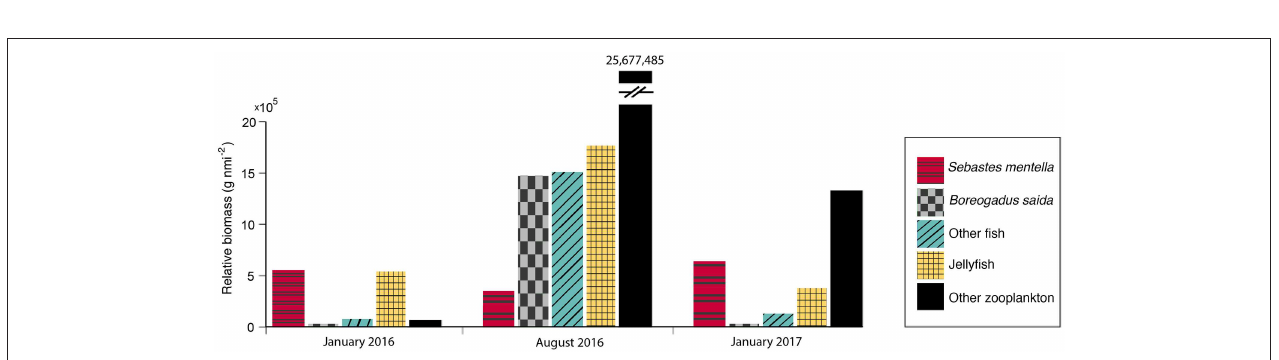
FIGURE 2 | Temperature-salinity diagrams averaged for each season with a 5-m vertical resolution. Bubble size indicates the distribution of the pelagic organisms in the SSL and is proportional to the nautical area scattering coefficient at 38kHz (s A ; m 2 nmi − 2 ) averaged over the same 5-m strata. Isopycnals indicate potential density (kg m − 3 ) and the regions corresponding to Atlantic Water (AW) and Modified Atlantic Water (MAW) are indicated (based on water mass characteristics in Meyer et al., 2017).